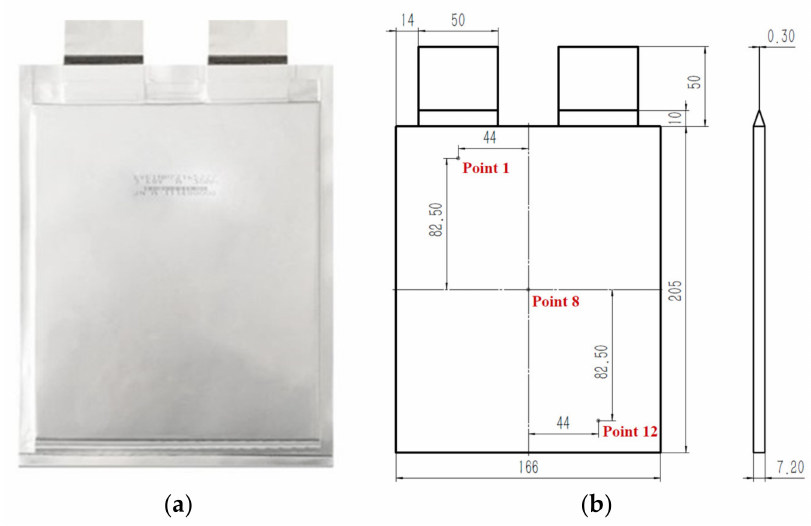
Figure 1. ( a ) Shape of the cell; ( b ) dimensions of the cell